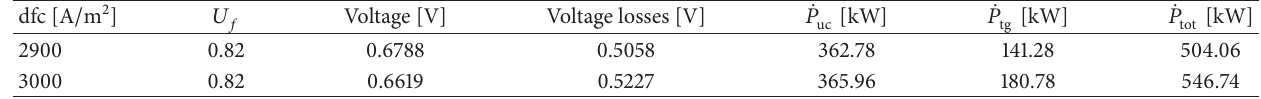
Table 8: Performance parameters for different dfc.